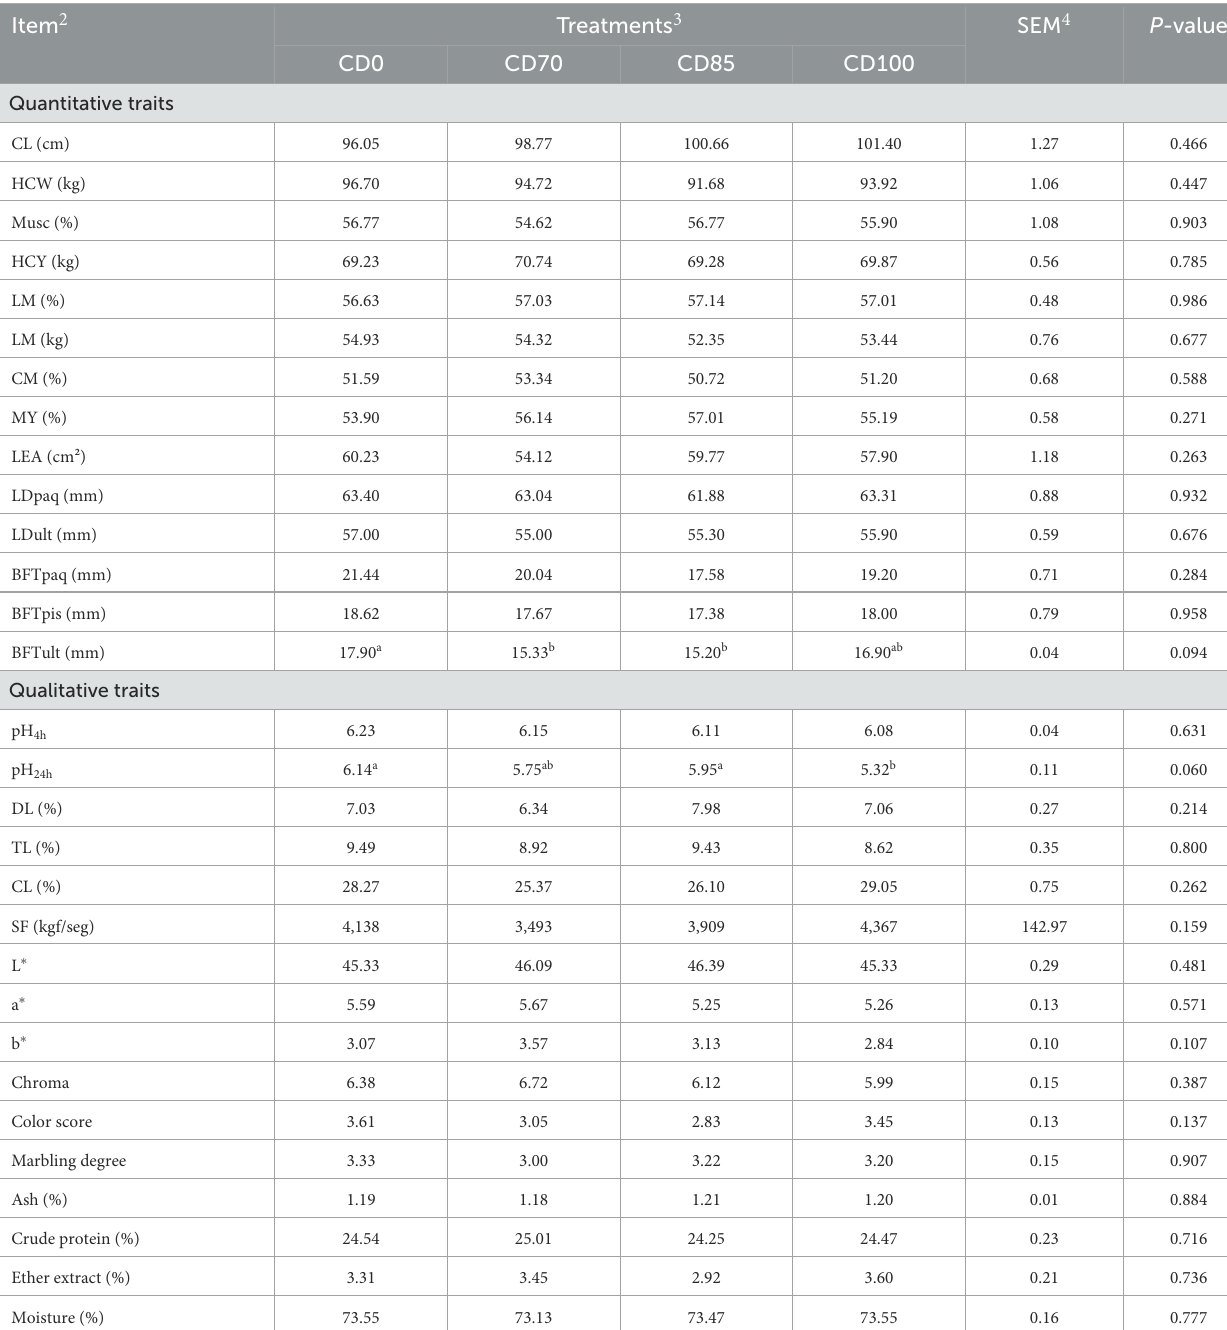
TABLE 5 Effect of β -mannanase supplementation in diets containing xylanase-phytase and reduced metabolizable energy on carcass traits and meat quality in finisher pigs on day 52 1